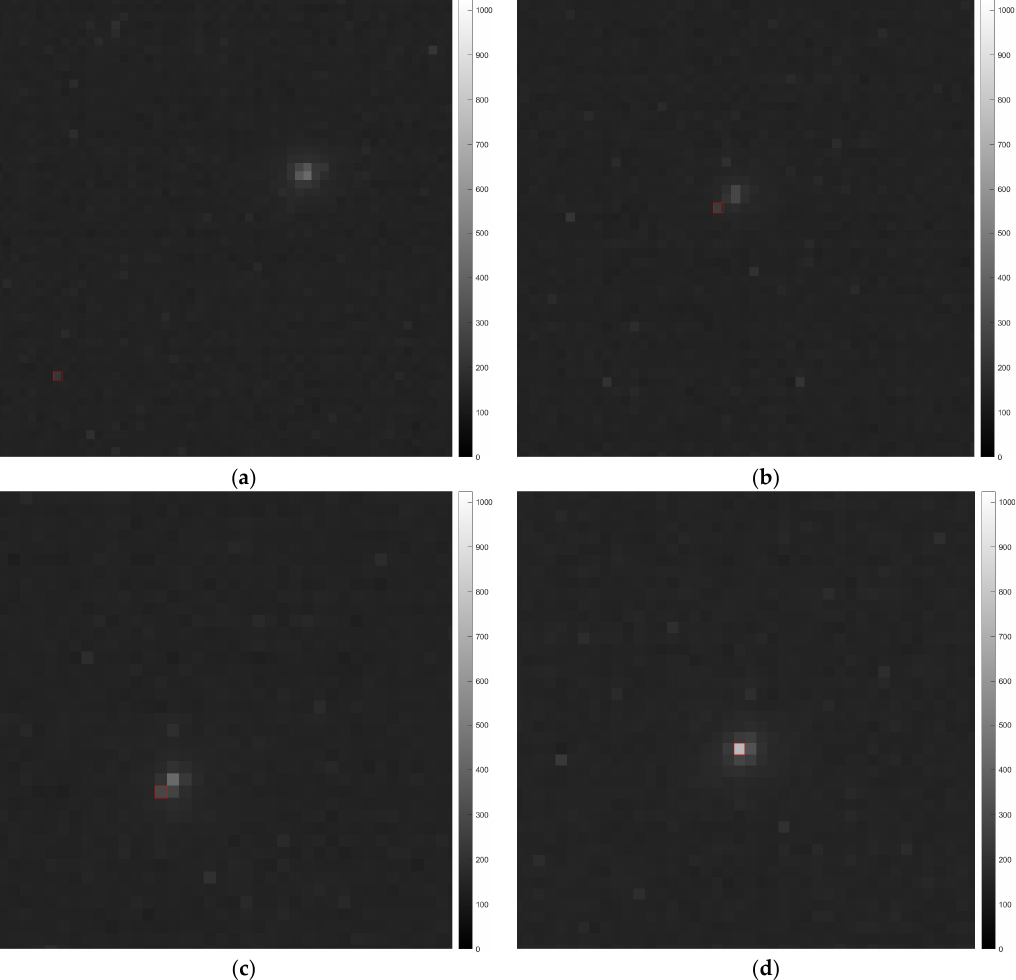
Figure 5. Different positional relationships of the hot pixel and the star: ( a ) the hot pixel is far away from the star; ( b – d ) the distance between the hot pixel and the center of the star is gradually approaching. Without the influence of hot pixels, the energy distribution of a star approximately obeys a two-dimensional Gaussian distribution, as shown in Equation (4).